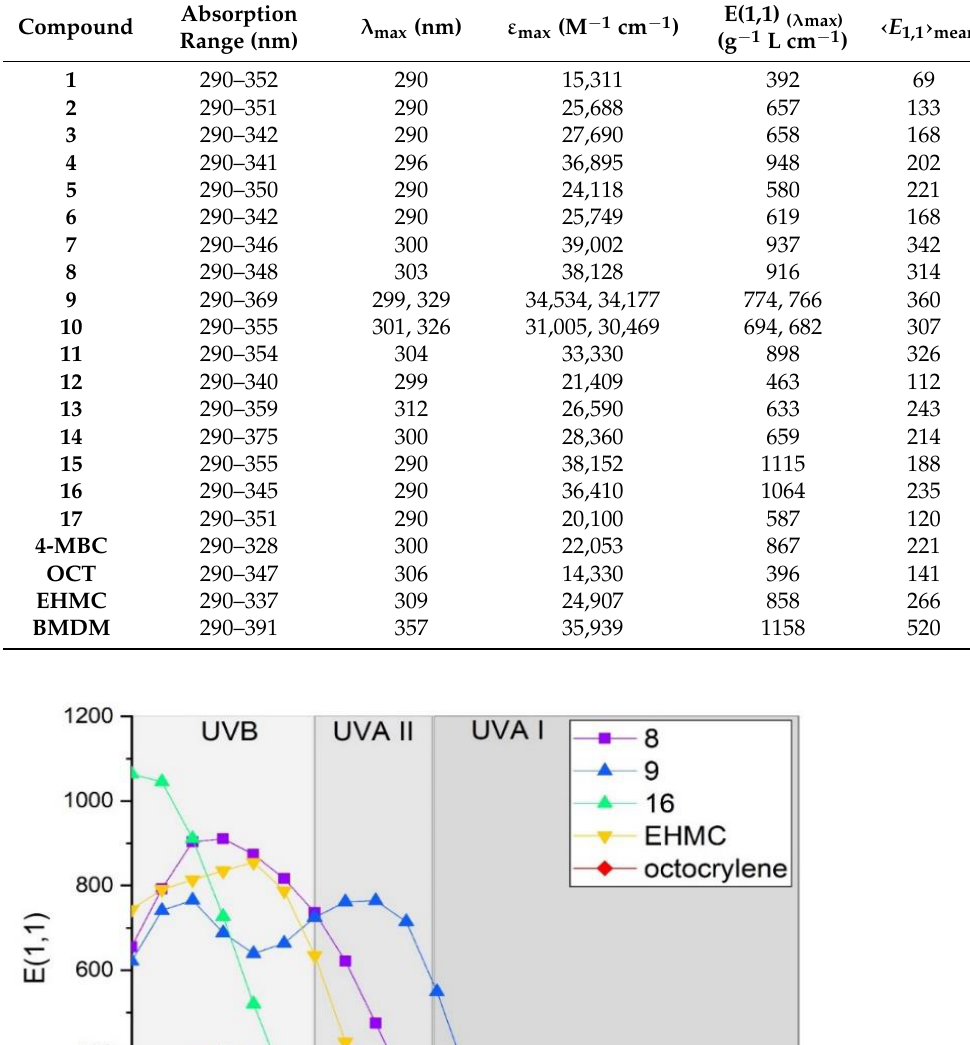
Table 2. Ultraviolet spectroscopic properties of the tested xanthone derivatives and reference UV filters obtained in chloroform solutions.